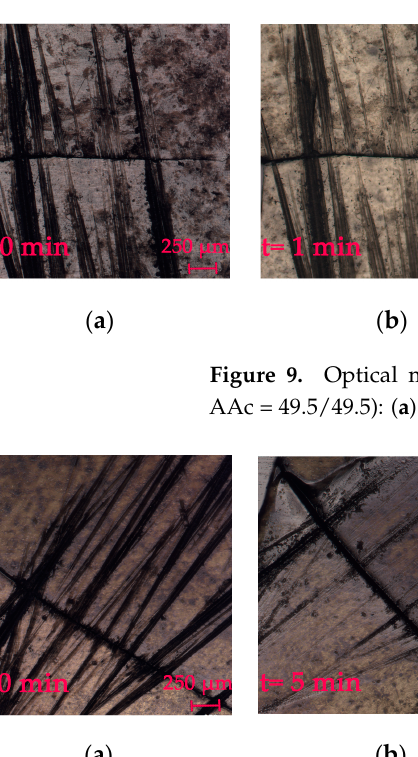
25 Table 5. Assessment of healing efficiency in relation to the modulus of elasticity. Sample